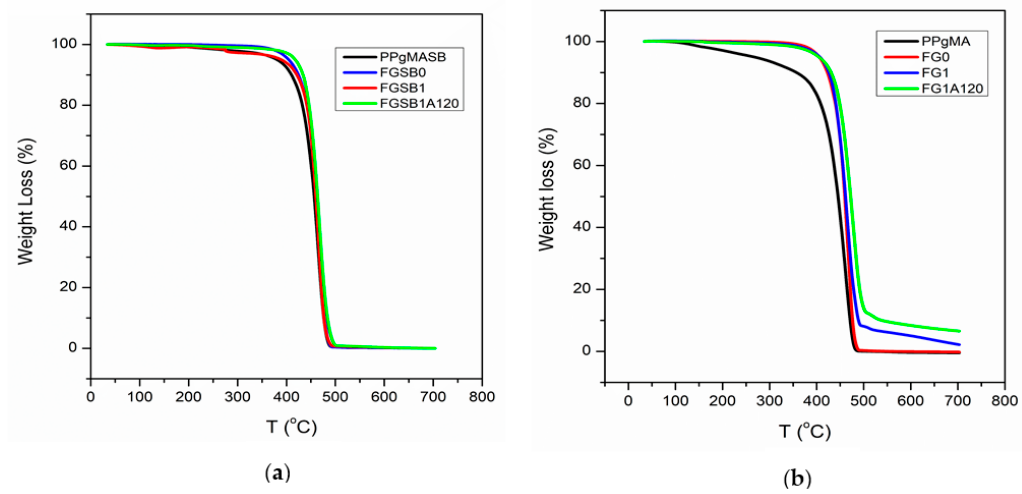
Figure 11. TGA thermograms of PPgMASB ( a ) and PPgMA ( b ) and their modified products.